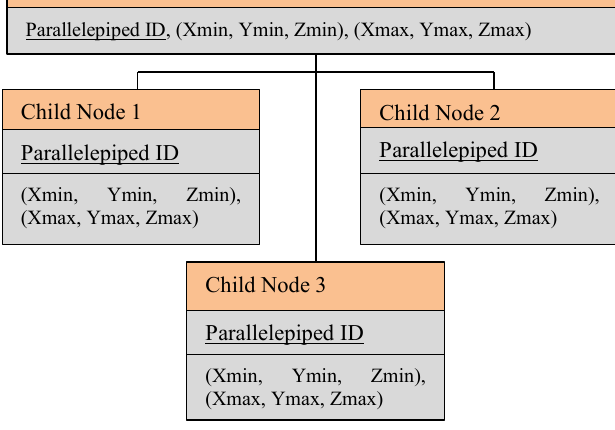
Figure 1. Clustered Hierarchical Tree